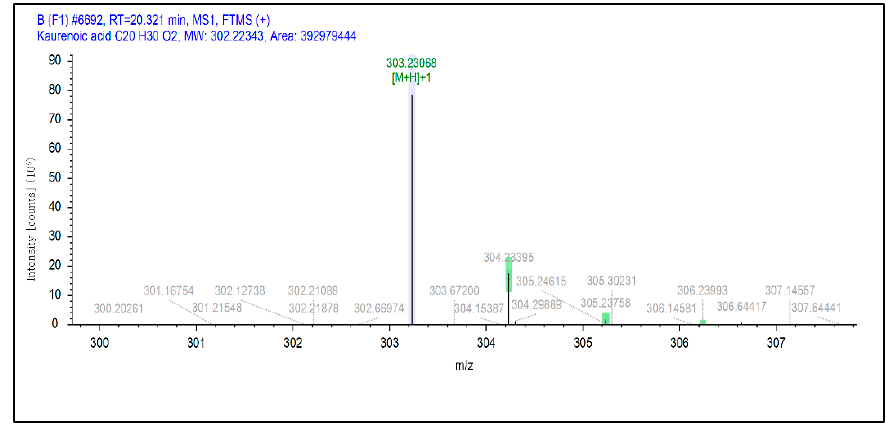
Figure 4. The molecular docking results of kaurenoic acid against the melanogenesis-related proteins ( A ) TYR and ( B ) MC1R. The chemical bond ligand–protein interaction of kaurenoic acid with ( C ) TYR and ( D ) MC1R.